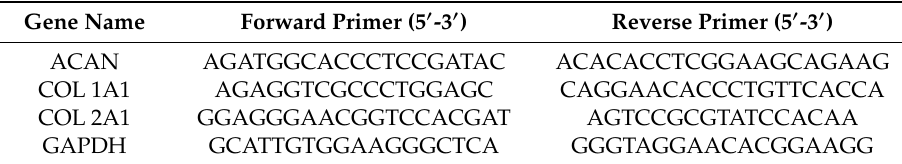
Table 2. Primers used for gene